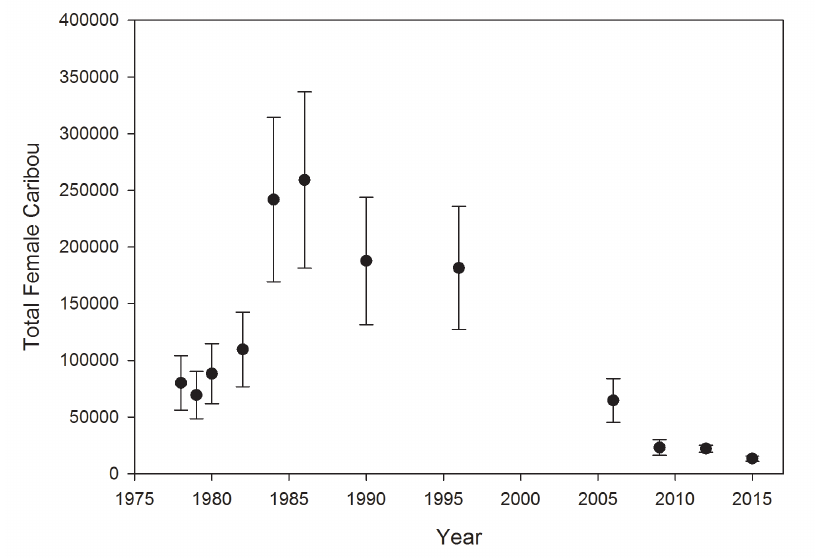
Figure 1. Temporal trend in number of females from the Bathurst caribou herd, 1976 to 2015.